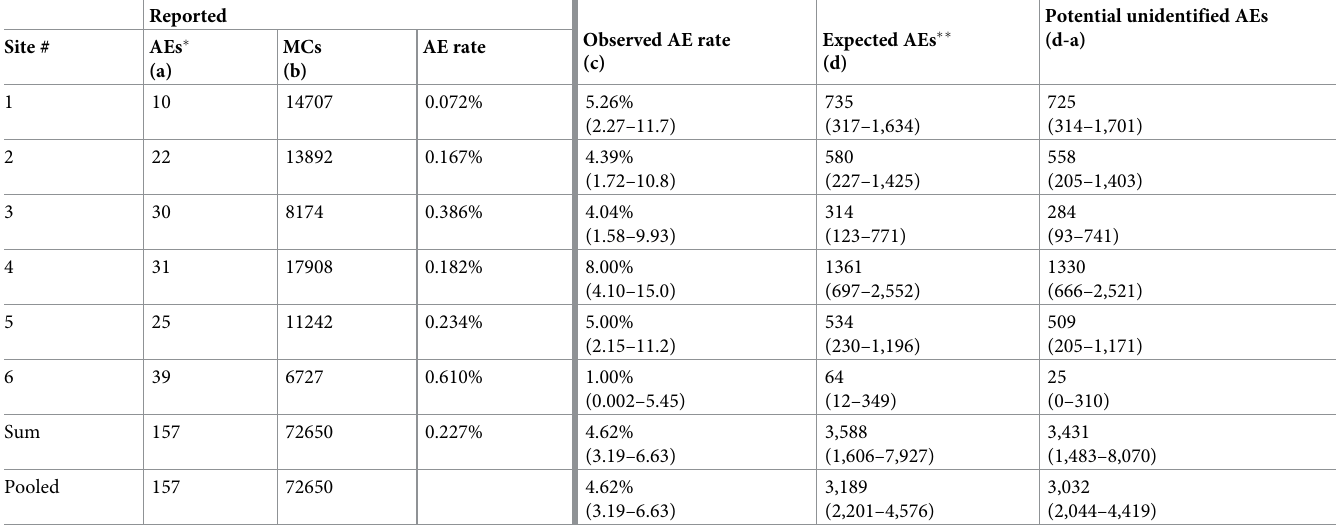
Table 3. Potential missed adverse events in 6 study sites: October 2014- September 2017.